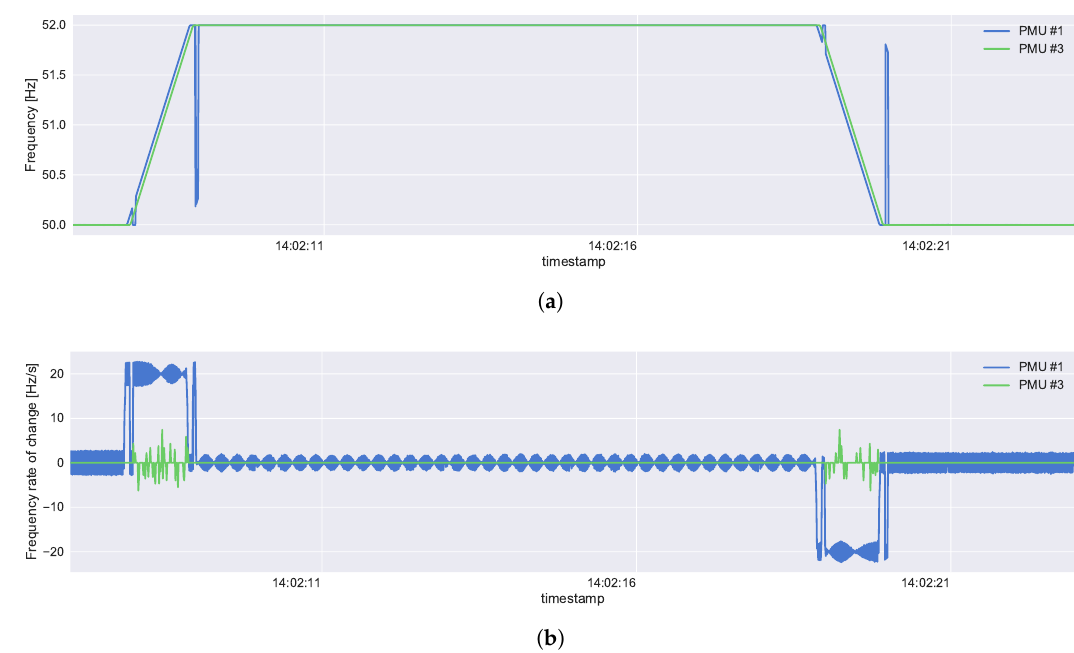
Figure 14. ROCOF Test: ( a ) resulting frequency measurements of two PMUs following a frequency ramp; ( b ) resulting frequency delta/deviations of two PMUs following a frequency